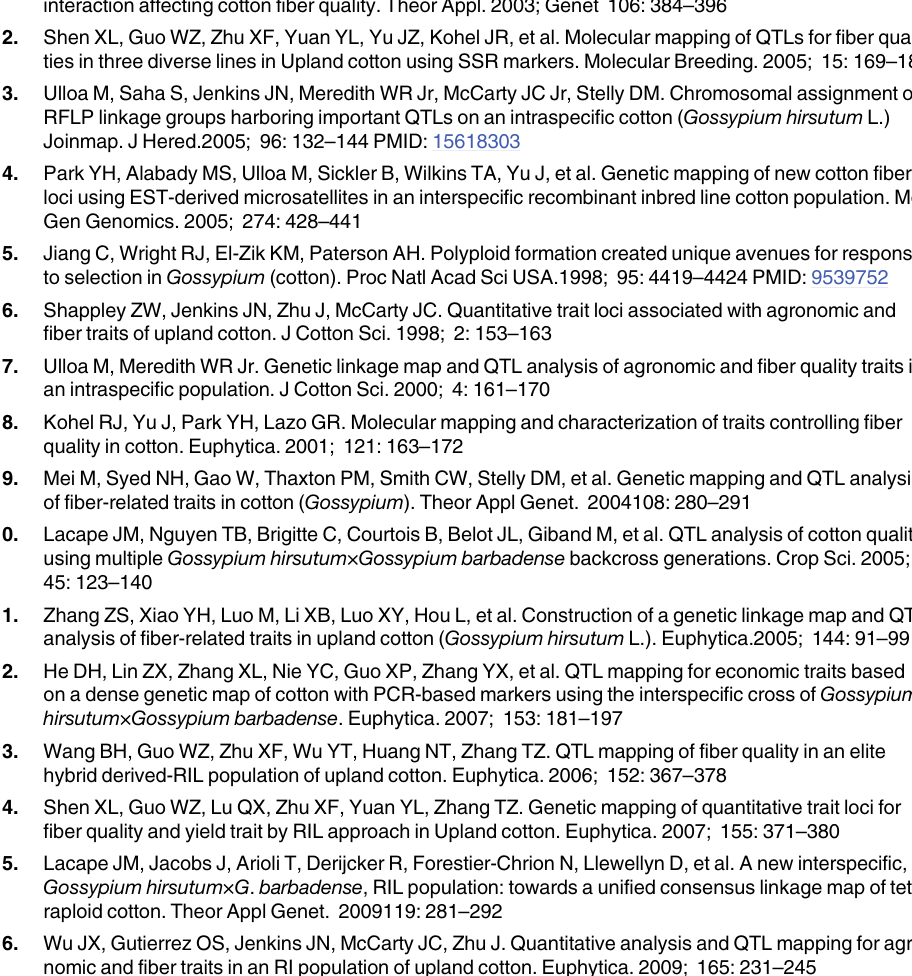
S1 Fig. Genetic mapping and major QTL mapping of chromosome 25.